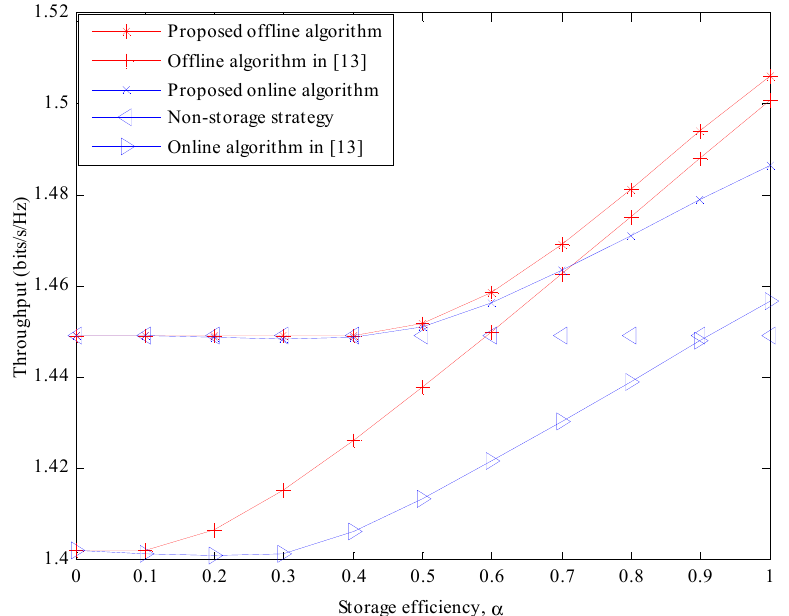
Figure 3. Throughput for the time-invariant channel with energy arrivals obeying the uniform distribution of [5, 20] mJ.